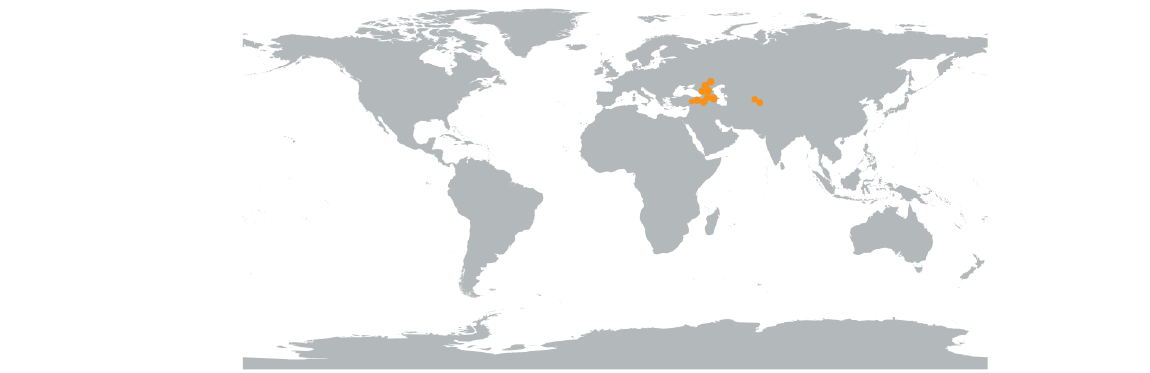
Fig. 17. Distribution of Malus orientalis Uglitzk. ex